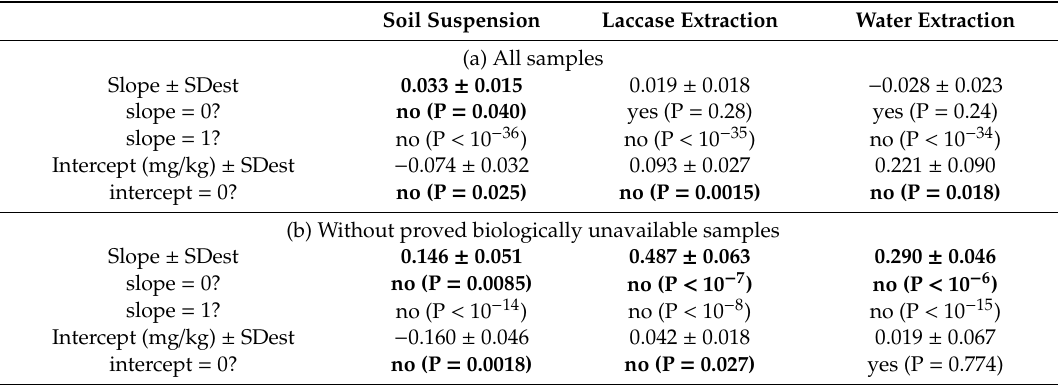
Table 4. Statistical evaluation of linear dependences (weighed regression) of Hg concentrations estimated by bioreporter on values determined by means of instrumental analysis; bold font indicates statistically significant results based on the hypothesis in the left